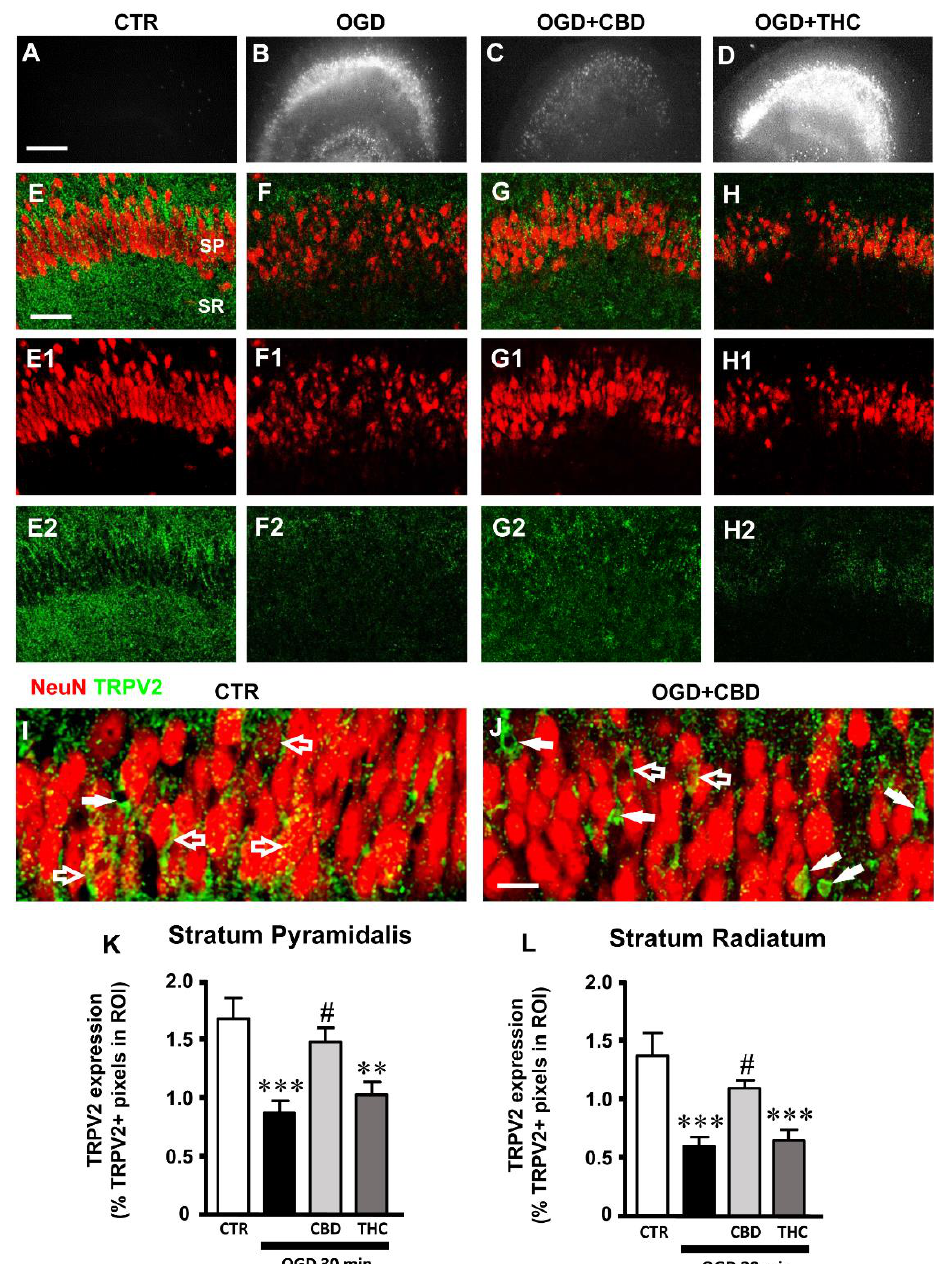
Figure 1. ( A – D ) Representative images of PI fluorescence in control ( A ), OGD ( B ), OGD + CBD, and OGD+ THC slices. Scale bar: 200 µm. ( E – H 2) Representative confocal images of immunostaining of neurons (NeuN, red) and TRPV2 channels (TRPV2, green) in CA1 SP and SR of CTR ( E - E 2), OGD ( F – F2 ), OGD + CBD ( G – G2 ), and OGD + THC ( H – H 2) slices. Images are z-projections of a single confocal z-scan captured with a 20× objective (total thickness: 1.2 µm). Scale bar: 75 µm. ( I – J ) Representative confocal images of immunostaining of neurons (NeuN, red) and TRPV2 channels (green) in CA1 SP of a CTR ( I ) and an OGD + CBD slice ( J ). Images are z-projections of a single confocal z-scan captured with a 40× objective (total thickness: 0.6 µm). Scale bar: 20 µm. ( I ) In CTR slices, the expression of TRPV2 was localized mainly on pyramidal neurons (open arrows). ( J ) In OGD + CBD slices, the expression of TRPV2 was localized mainly on non-neuronal cells (white arrows). ( K ) Quantitative analyses of TRPV2 channel expression in CA1 SP of CTR (n = 11), OGD (n = 10), OGD + CBD (n = 9), and OGD + THC slices (n = 9). Statistical analysis: one-way ANOVA p < 0.001; Newman – Keuls post hoc test *** p < 0.001 and ** p < 0.01 vs. CTR, # p < 0.05 vs. OGD. ( L ) Quantitative analyses of TRPV2 channel expression in CA1 SR of CTR (n = 12), OGD (n = 10), OGD + CBD (n = 8),